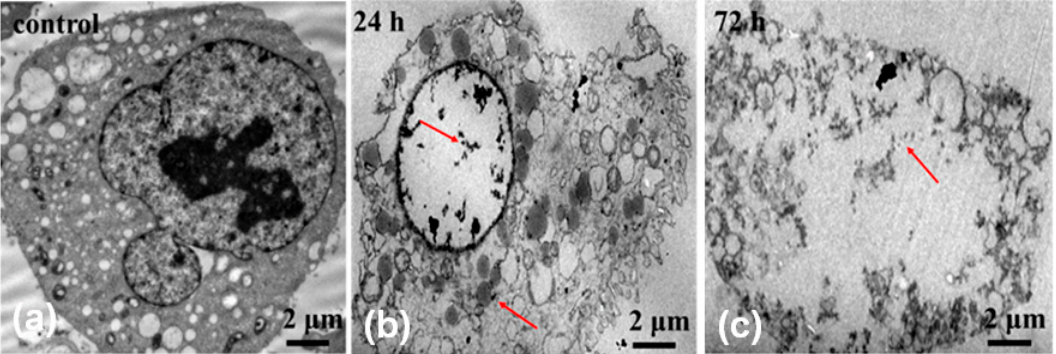
Figure 5. TEM micrographs of OCM-1 cells incubated with ( a ) the control, ( b ) 4 µg/mL MMC-TG for 24 h, and ( c ) 4 µg/mL MMC-TG for 72 h: The arrows in Figure 4b,c indicate the presence of MMC-TG inside the cells.